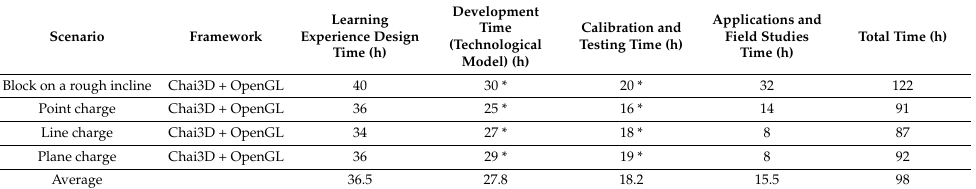
Table 2. Times used for the development of the different phases of the visuo-haptic environments without VIS-HAPT methodology. Data marked with * were reported in